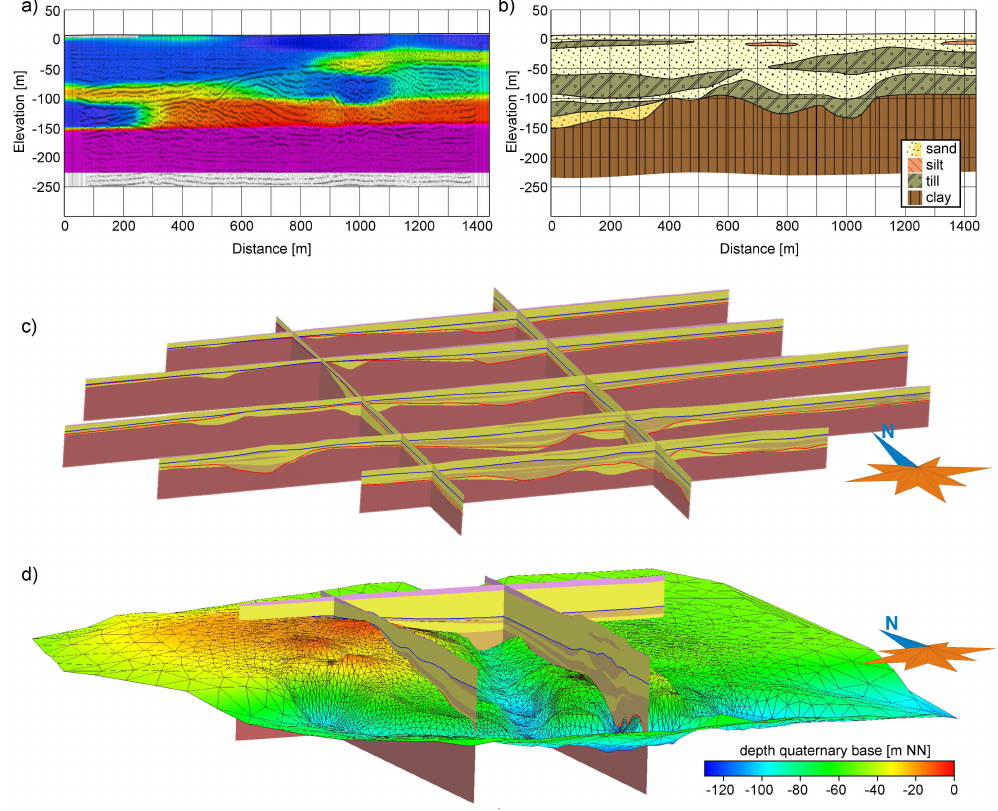
Fig. 5. Development of 3-D model: (a) seismic reflection profile with overlying SkyTEM resistivity values (for colorscale see Fig. 4d); (b) geological cross-section from boreholes, seismic reflections, and SkyTEM resistivity values; (c) fence diagram of construction cross- sections used to generate the 3-D model (yellow: aquifers; brown/red: aquitards; blue line: base of 2nd aquifer; red line: base of Quaternary strata)(the view is 5-times exaggerated); and (d) 3-D view into the 3-D model showing one layer (Quaternary base) and three construction cross-sections (the view is 20-times